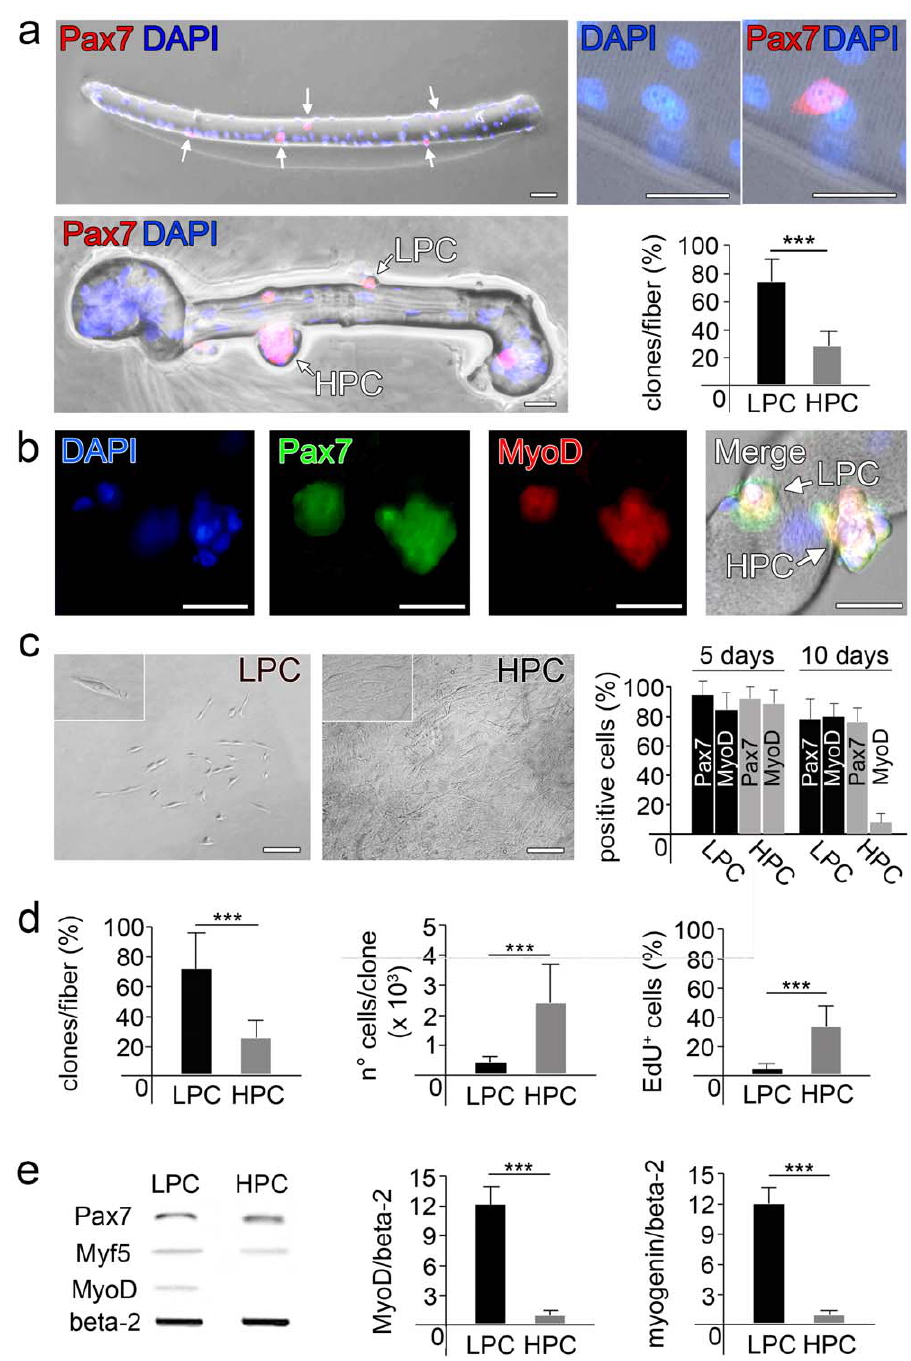
Figure 1. Identification and characterization of 2 subpopulations of SCs. (a) Evaluation of the average number of SCs per single fiber. Isolated FDB single fibers were immunostained with anti-Pax7 antibody and merged with DAPI immediately after isolation, in order to count the SCs (white arrows) per fiber (top panel left; high magnification on top panel right). Single fibers were also cultured in suspension for 5 days and SCs were evaluated. LPC and HPC are distinguishable on the fiber (indicated with LPC and HPC). SCs were immunostained with anti-Pax7 antibody and merged with DAPI (bottom left, bar=100 m m). In the diagram percentage of LPC and HPC per single fiber (n=50) is reported (bottom right, mean 6 s.d., ***p , 0.001). (b) Immunostaining for Pax7 and MyoD, merged with DAPI, was performed on both LPC and HPC on fiber, showing that SCs in both clones are positive for such markers after 5 days in suspension culture (bar=100 m m). (c) Cloning of freshly isolated SCs through limiting dilutions in 96-well dishes. LPC and HPC are distinguishable after phase-contrast microscope analyses (left, bar=100 m m, insets with higher magnification). In the diagram on the right the % of cells staining positive for Pax7 and MyoD, both in LPC and in HPC, after 5 and 10 days of culture respectively, is reported. (d) In the diagram on the left, percentage of LPC and HPC derived from cloning of freshly isolated SCs per single fiber, then diagrams showing that average number of cells (center) and percentage of EdU-positive cells in LPC and HPC (mean 6 s.d., ***p , 0.001) (right). (e) Semiquantitative PCR analysis for myogenic markers Pax7, Myf5 and MyoD (house-keeping gene: beta-2-microglobulin) (left), and real-time PCR analysis for MyoD (center) and myogenin (right) (mean 6 s.d., ***p , 0.001, normalized against housekeeping gene beta-2-microglobulin) on pools of LPC and HPC.